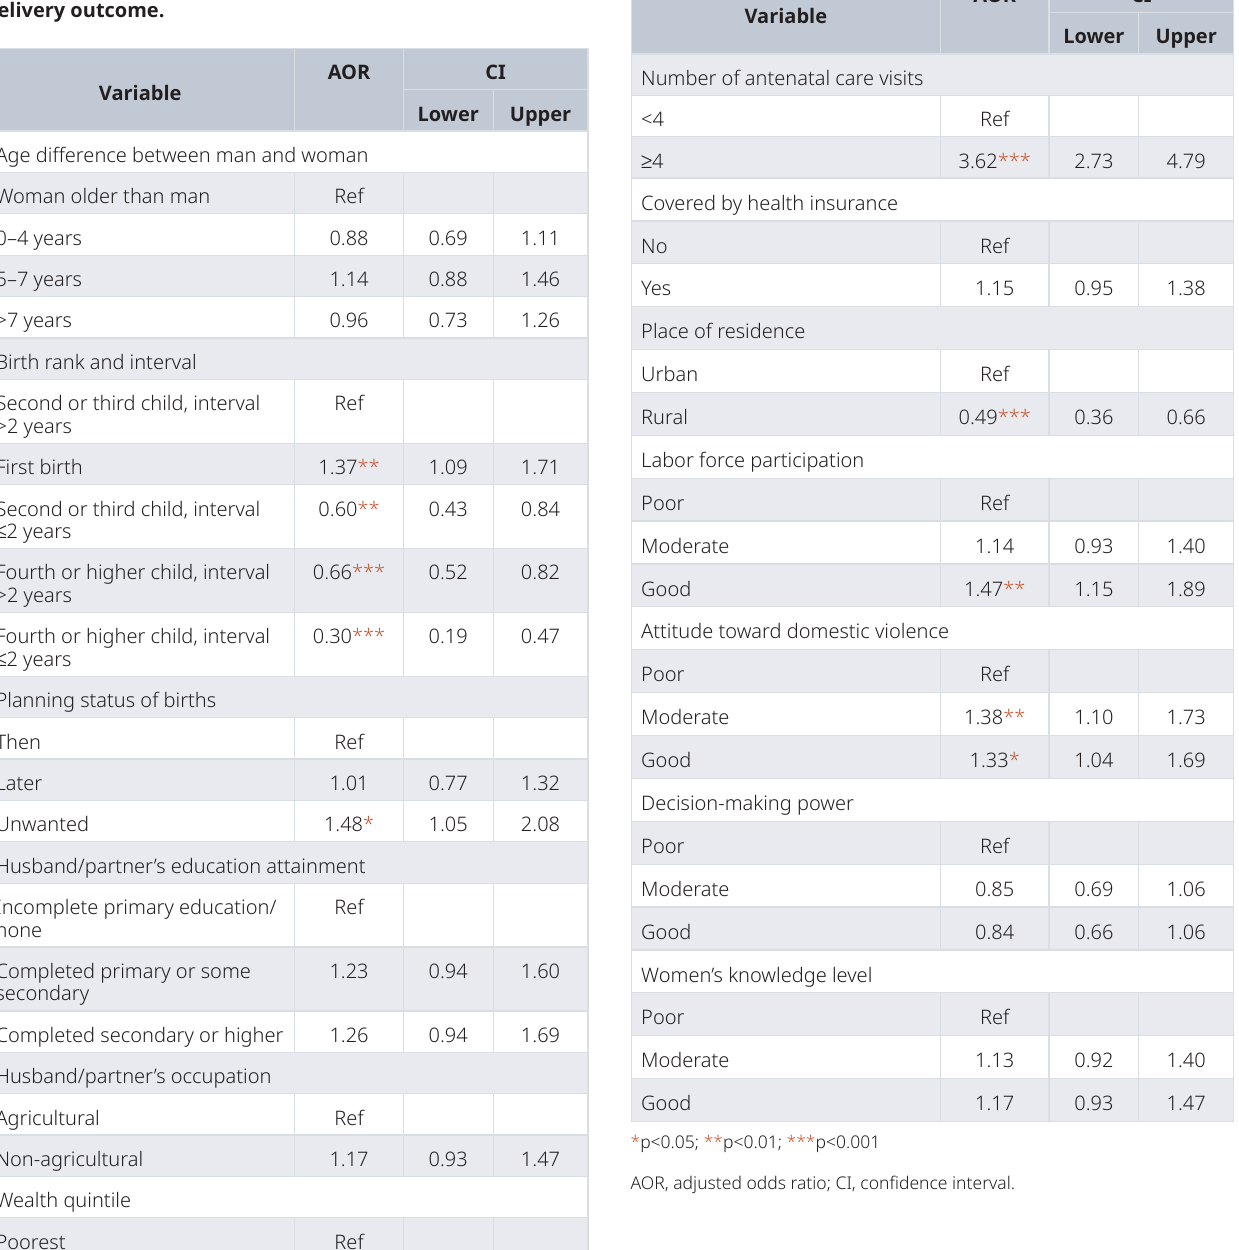
Table 4. Binary logistic regression analysis with a place of delivery